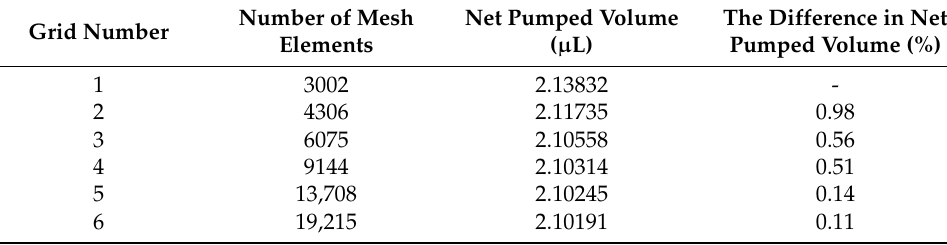
Table 3. Net pumped volume for each grid